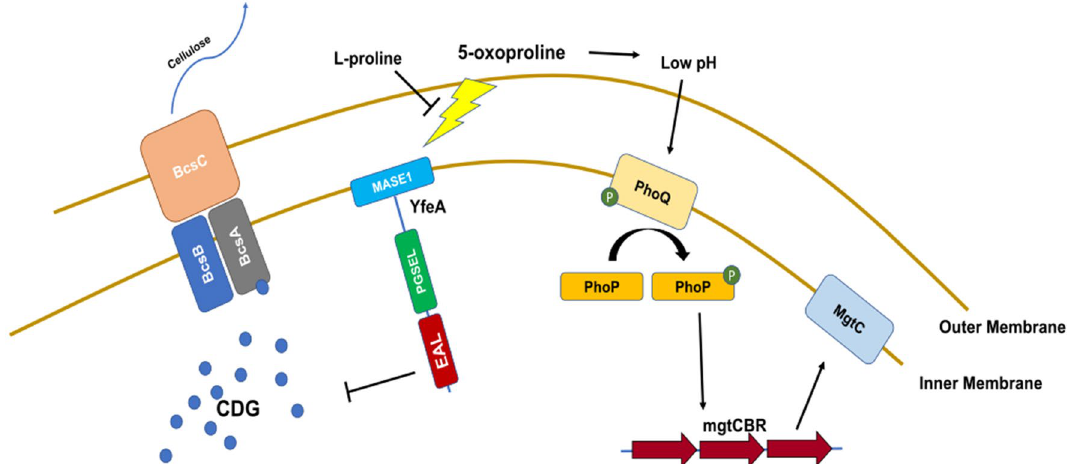
Figure 7. Model of 5OP sensing by Salmonella . Shown are the two suggested pathways. A pathway which responds specifically to 5OP, in which YfeA is activated to reduce c-di-GMP levels, thereby reducing cellulose secretion by the BCS machinery, resulting in reduced cellular aggregation. A second pathway is activated by 5OP in a non-specific manner by the reduction in pH levels. In this pathway, PhoPQ is activated to upregulate mgtCBR operon